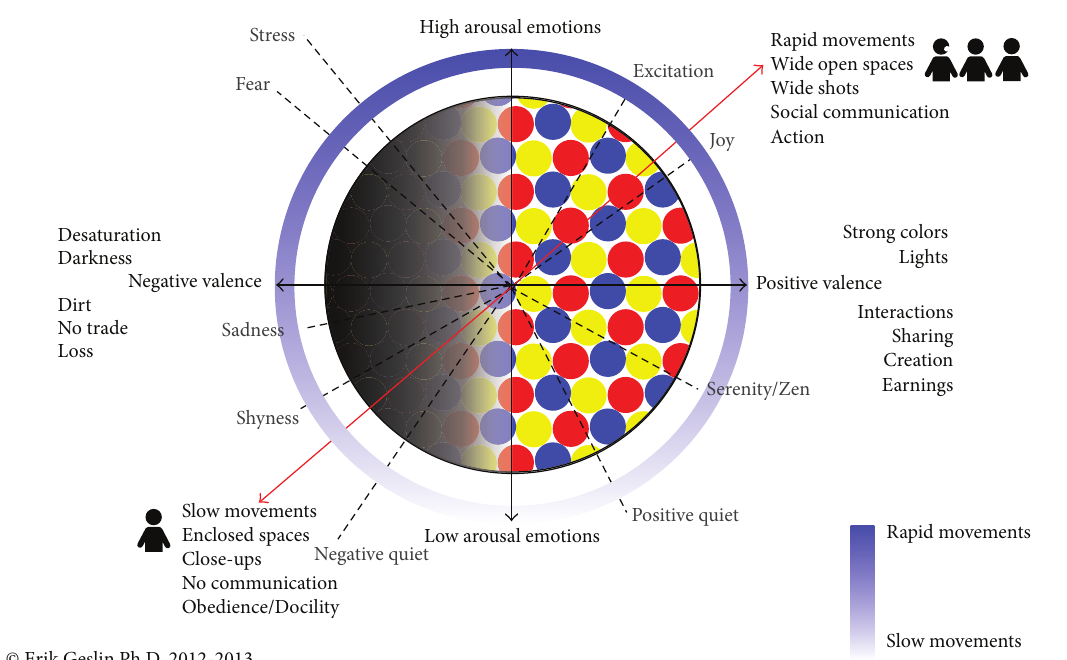
Figure 1: Circumplex model of induction of emotions in video games